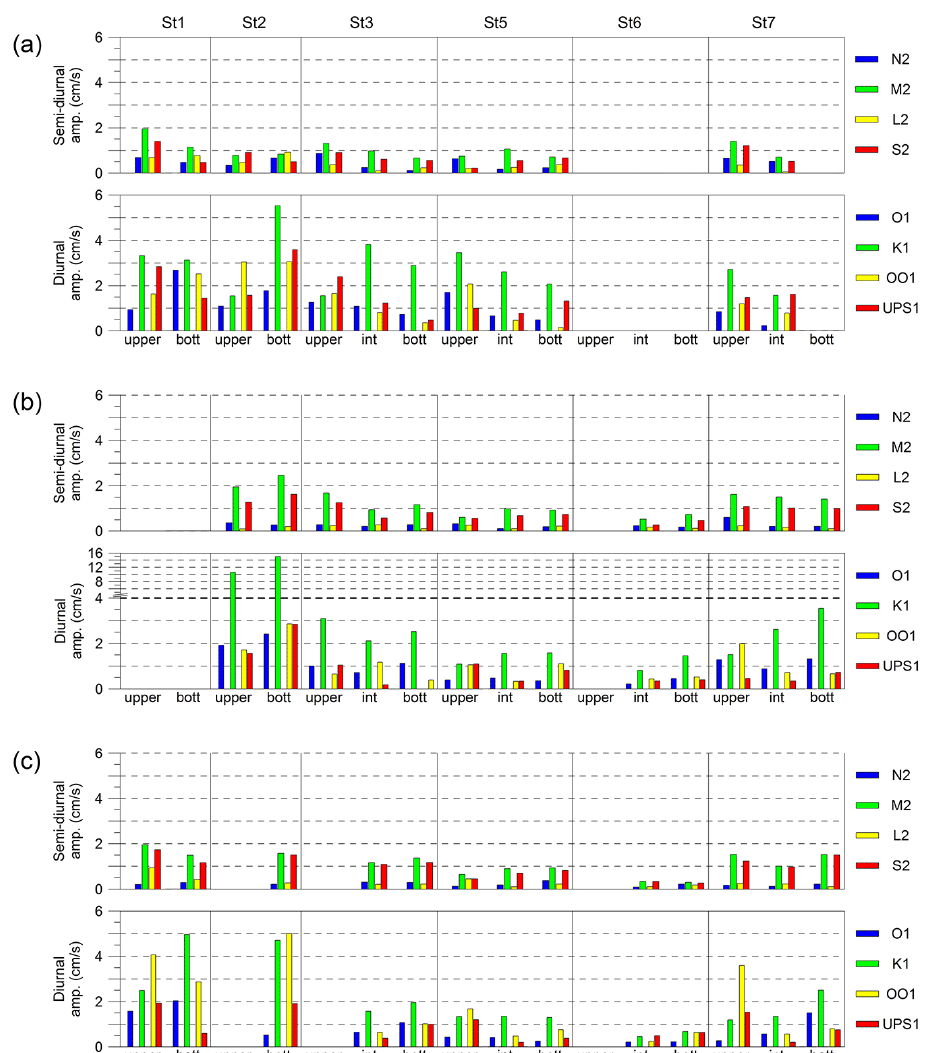
Fig. 6. Semi-major axes of the tidal ellipses for the diurnal and semi-diurnal tidal constituents, obtained from the harmonic analysis applied to the periods PR1 (a) , PR2 (b) and PR3 (c) of the OTRANTO/OGEX projects. Upper, intermediate (int) and bottom (bott) layers are indicated. Please note the change of the amplitude scale for the diurnal plot in (b)